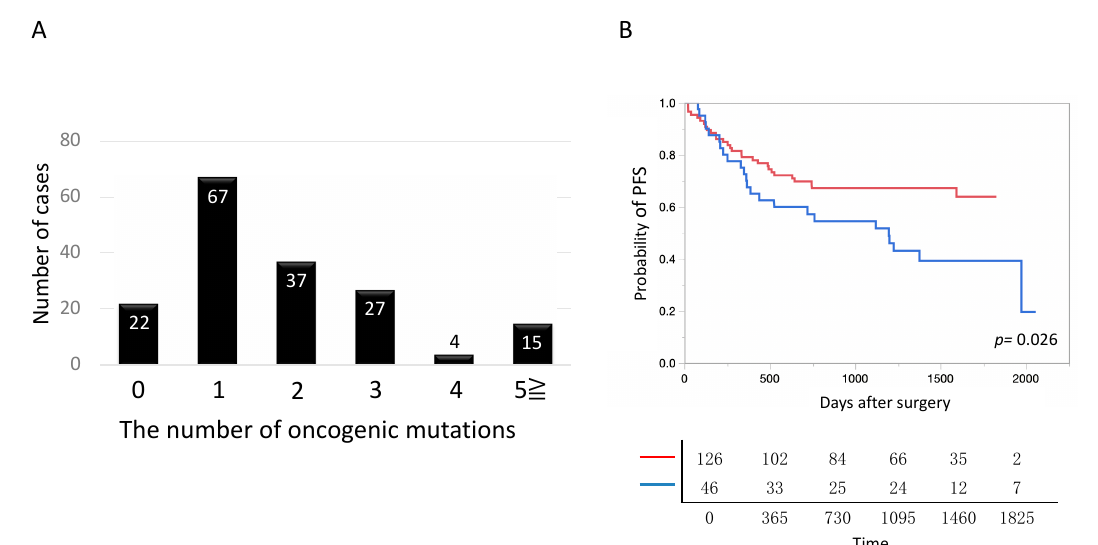
Figure 3. Number of pathogenic mutations in lung cancer. ( A ) The number of mutations harbored by each tumor is shown. Tumors harboring one mutation were most common. On average, tumors harbored 2.6 mutations. ( B ) The postoperative prognosis was significantly poorer in lung cancer, harboring three or more oncogenic mutations, than harboring 2 or less oncogenic mutations. Blue and red lines denote lung cancer harboring three or more oncogenic mutations ( n = 46) and that harboring 2 or less oncogenic mutations ( n = 126), respectively.